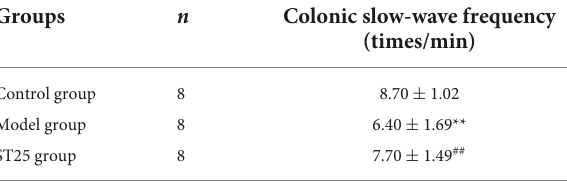
TABLE 1 Effect of electroacupuncture at ST25 on colonic slow-wave discharge in irritable bowel syndrome (IBS) model rats.